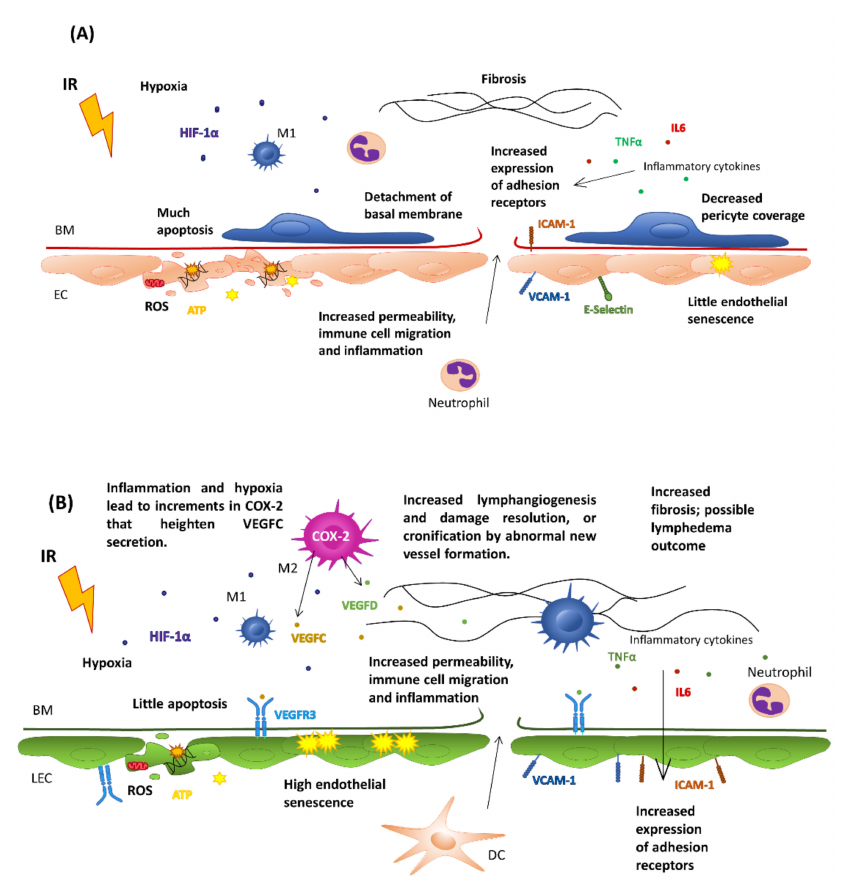
Figure 2. Effects of Ionizing Radiation on the Blood ( A ) and Lymphatic vasculature ( B ). IR, irradiation; HIF-1 α , hypoxia-inducible factor 1; M1, macrophage type 1; M2, macrophage type 2; BM, basal membrane; EC, endothelial cell; LEC, lymphatic endothelial cell; ROS, radical oxygen species; ICAM-1, intercellular adhesion molecule 1; V-CAM, vascular cell adhesion molecule 1; TNF α , necrosis tumoral alfa; IL, interleukin; ATP, adenosine triphosphate; VEGFC, vascular endothelial growth factor C; VEGFD, vascular endothelial growth factor D; COX2, cyclooxygenase-2; DC, dendritic